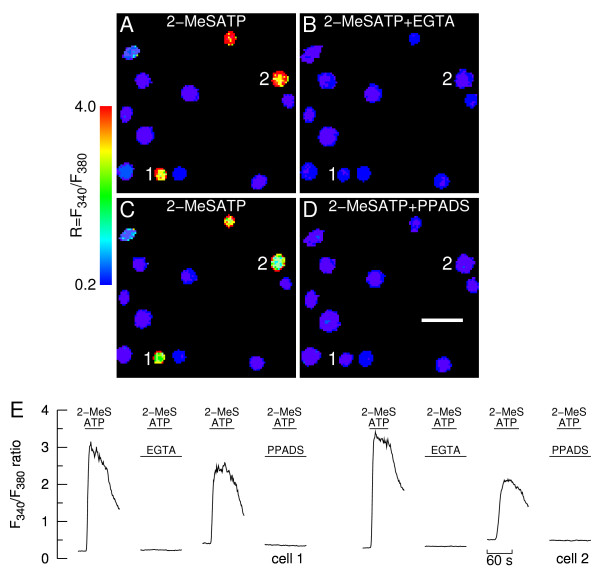
Effects of PPADS and extracellular Ca2+ removal on calcium responses to 2-MeSATP. A-B. Calcium images showing a group of chromaffin cells during stimulation with 20 μM 2-MeSATP in presence of extracellular calcium (A) and during stimulation in the virtual absence of extracellular calcium ("2-MeSATP +EGTA", B); C-D. The cells were subsequently superfused with a Ca2+-containing solution and challenged with 2-MeSATP, in the absence (C) or presence of 50 μM PPADS ("2-MeSATP +PPADS", D). Calibration bar: 50 μm. More in the legend to Fig. 1(A-D); E. Time courses of changes in F340/F380 fluorescence ratio for two representative cells (cells 1 and 2, also depicted in A-D). The lines denote superfusions with 2-MeSATP, PPADS or EGTA-containing solution. The responses are representative of data from 3 experiments.